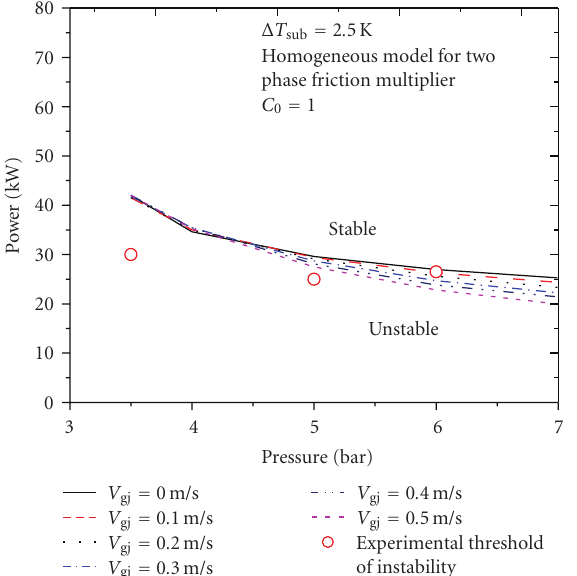
Figure 14: E ff ect of drift velocity on threshold of Type II instability observed in the Apparatus-A of Furutera.